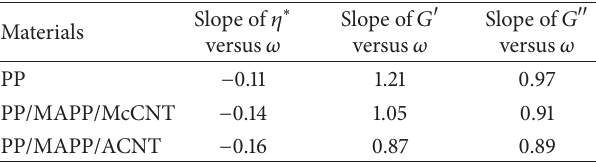
Figure 6: Complex viscosity versus frequency of PP and nanocom- posites. Table 2: Variations of low frequency slopes of 𝜂 ∗ , 𝐺 󸀠 , and 𝐺 󸀠󸀠 versus 𝜔 for PP and its